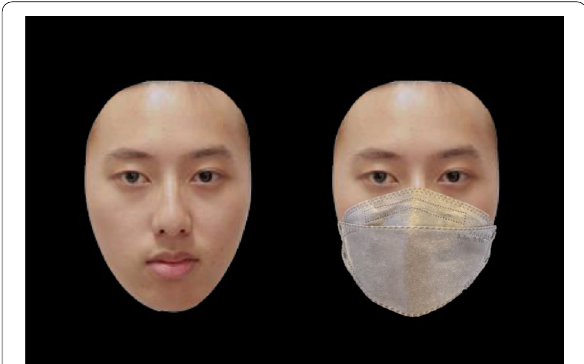
Fig. 1 Examples of an unmasked (left) and masked face stimuli